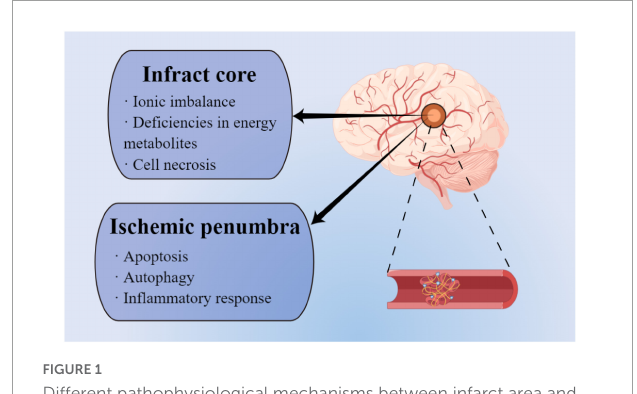
FIGURE1 Different pathophysiological mechanisms between infarct area and ischemic penumbra (by